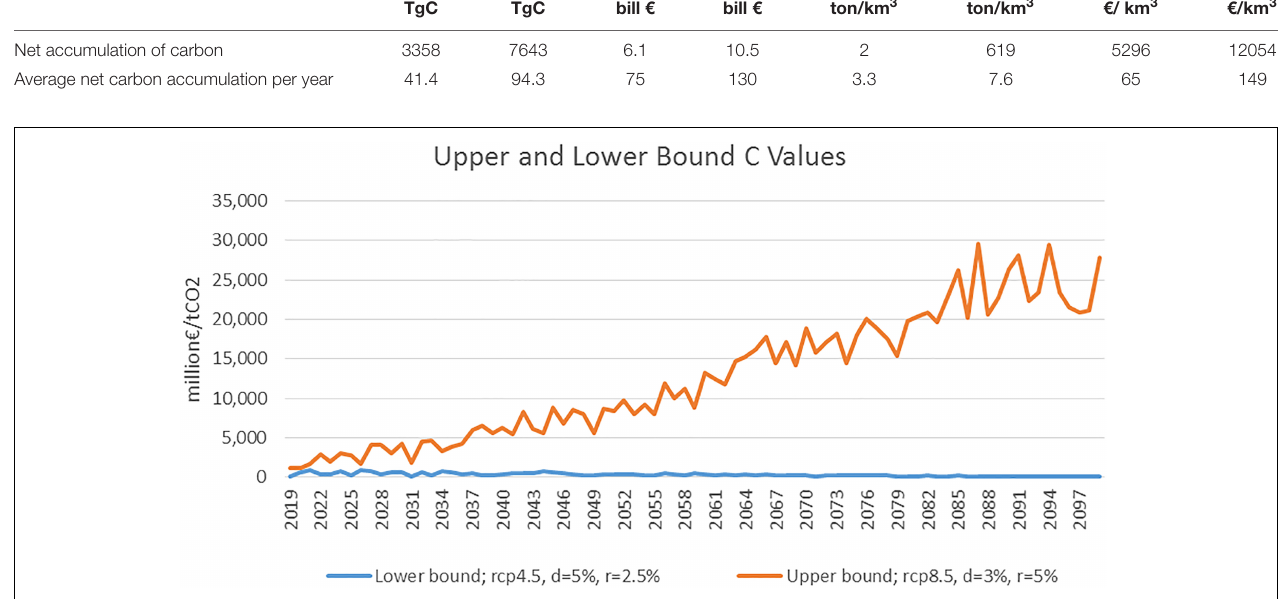
FIGURE 9 | Upper and lower bound of value of carbon in the Arctic Ocean, as present value in each year, discounted back to 2019, in million euros. The upper bound consists of RCP 8.5, a discount rate of 3% and a starting SCC price of €50 with a growth of 5%. The lower bound includes the RCP 4.5 scenario, a discount rate of 5% and starting ETS of €19.46 (November 2018), and growth rate in the price of